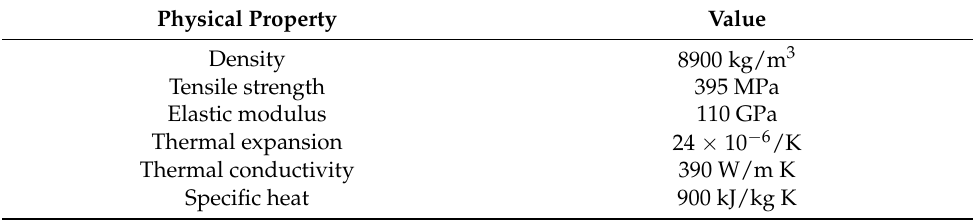
Table 3. Properties of copper at 25 ◦